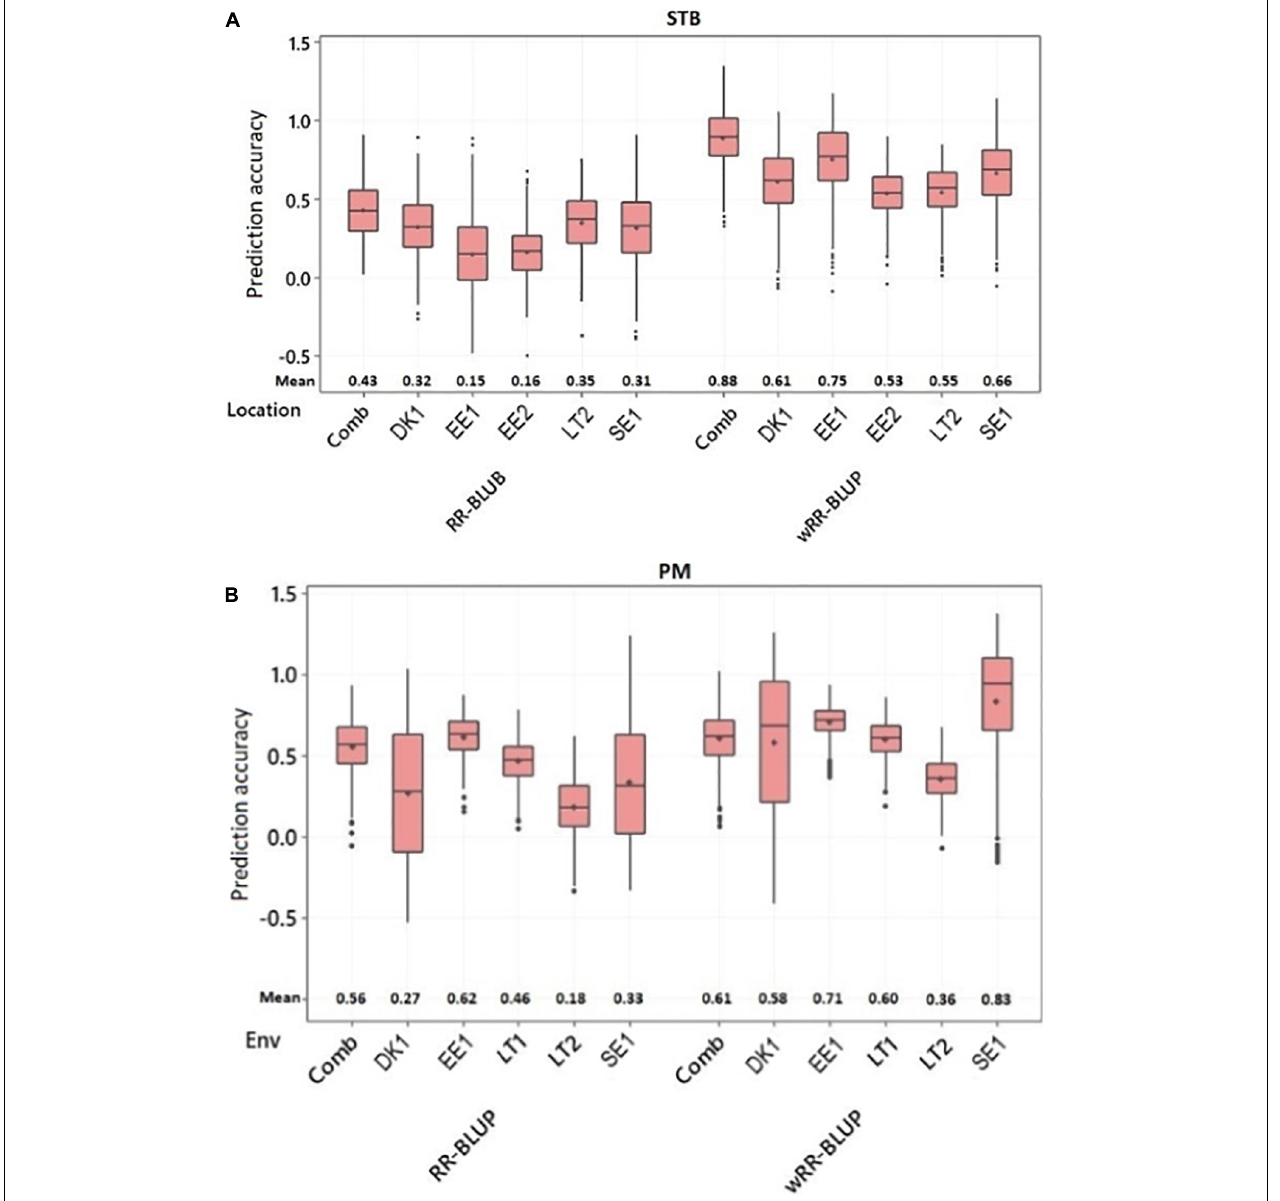
FIGURE 5 | Box plot for the genomic prediction accuracy of the ridge regression BLUP (RR-BLUP) and weighted RR BLUP (wRR-BLUP) models for adult-plant resistance to (A) STB and (B) PM. Comb, combined; EE, Estonia; LT, Lithuania; SE, Sweden; DK, Denmark; Years: 1, 2018-2019; 2,